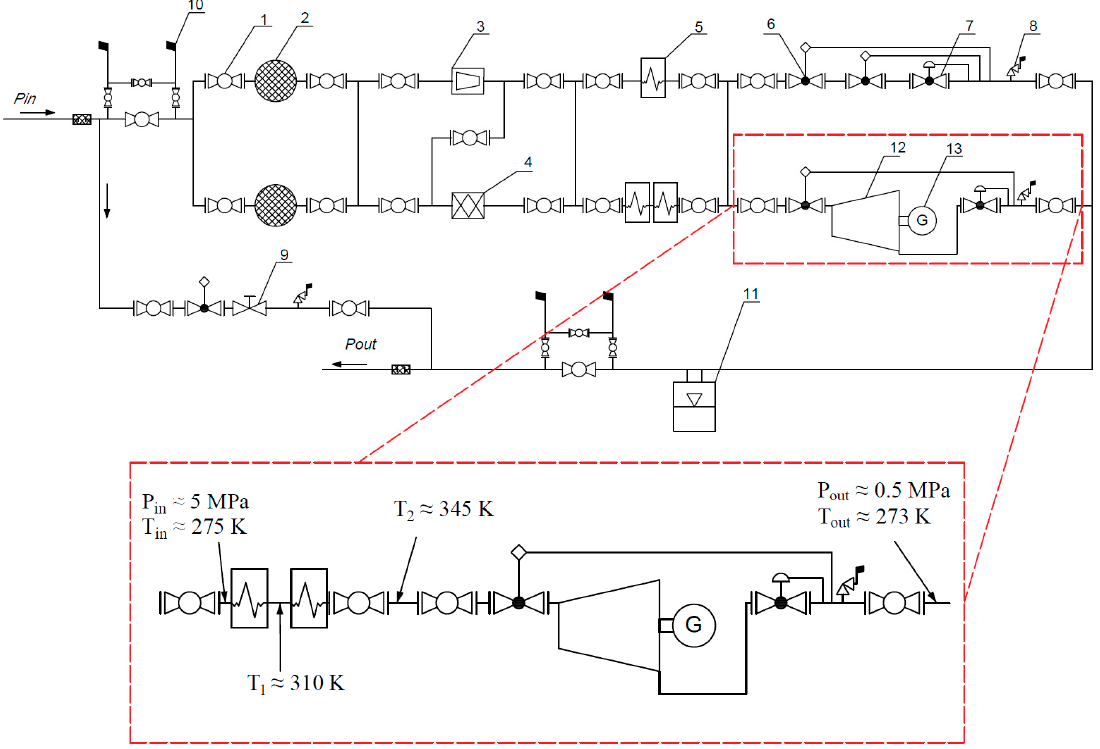
Figure 2. Schemes of Reducing and Metering Station (with turboexpander) . 1—Valve; 2—Filter; 3—Turbine gas meter; 4—Ultrasound gas meter; 5—Heat exchanger; 6—Shut down valve; 7—Pressure regulator; 8—Pressure drop valve; 9—Regulation valve; 10—Ventilation valve; 11—Gas odorizer; 12—Turboexpander; 13—Generator.